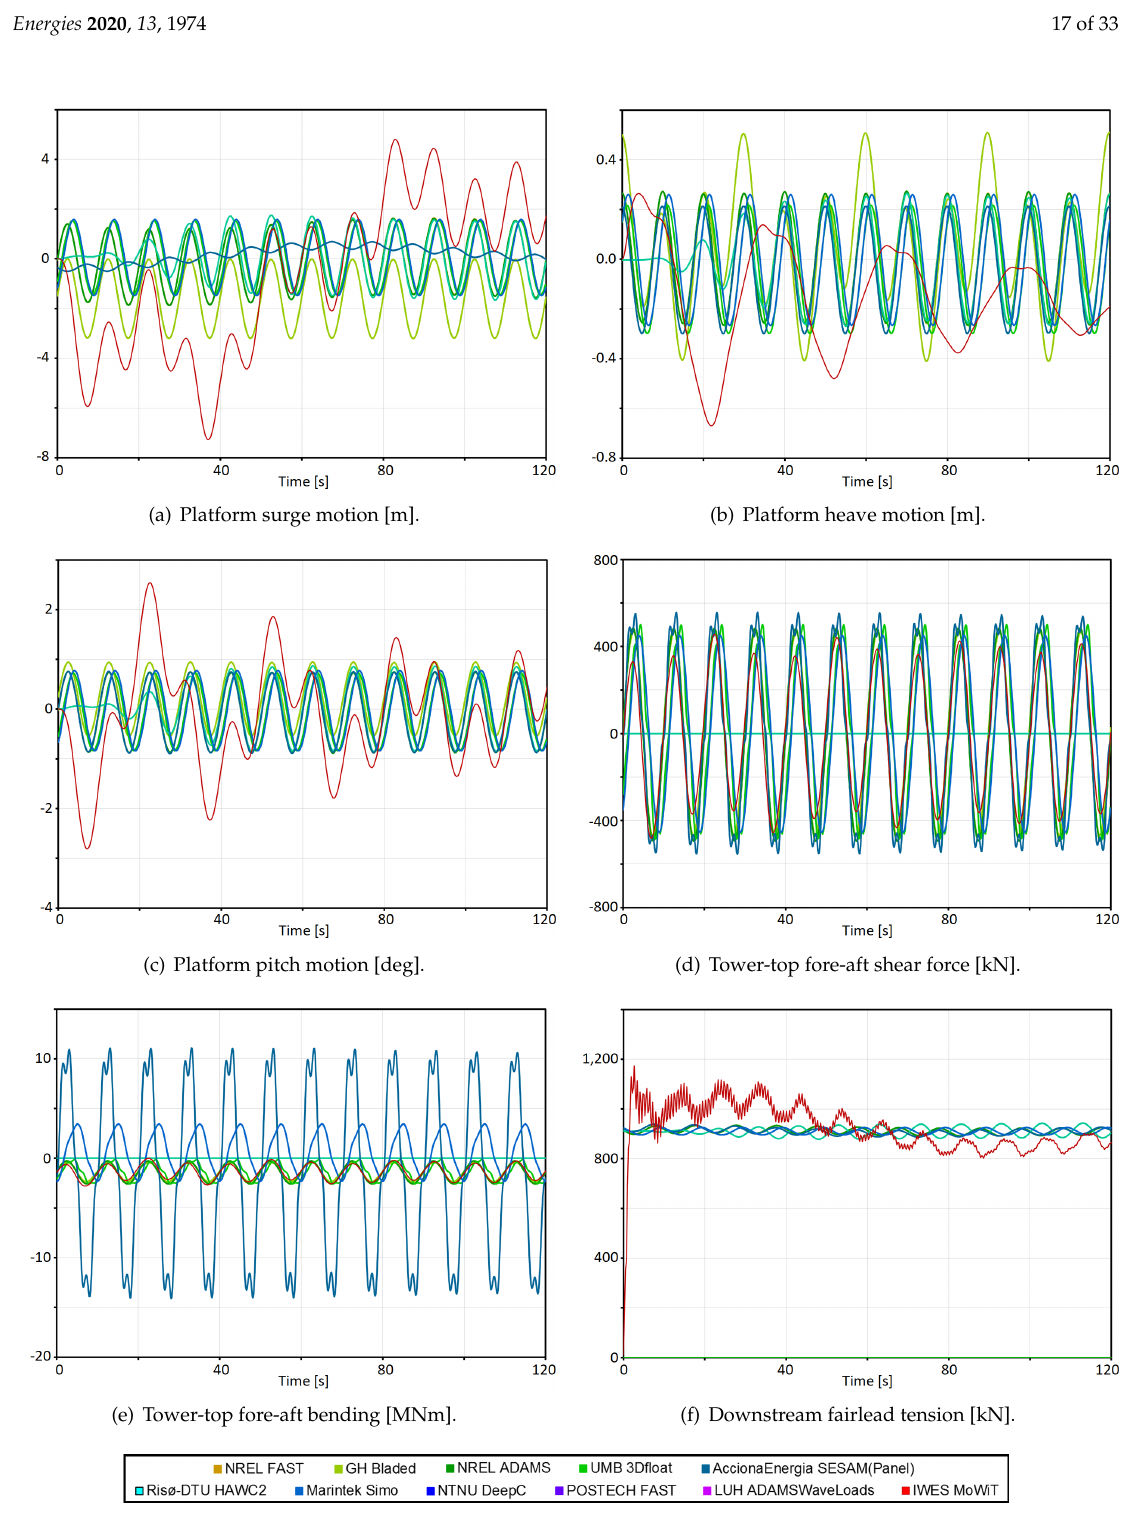
Figure 12. Hydro-elastic time series with regular waves from LC